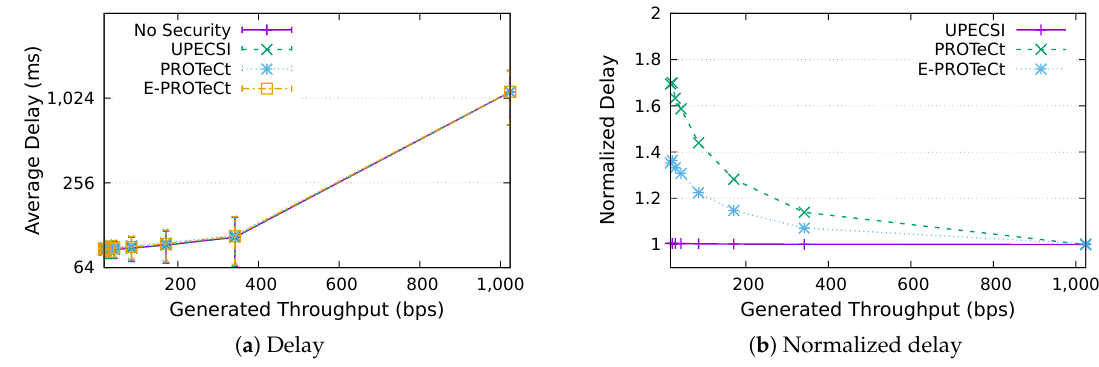
Figure 15. Delay analysis for an IoT network with 64 devices.